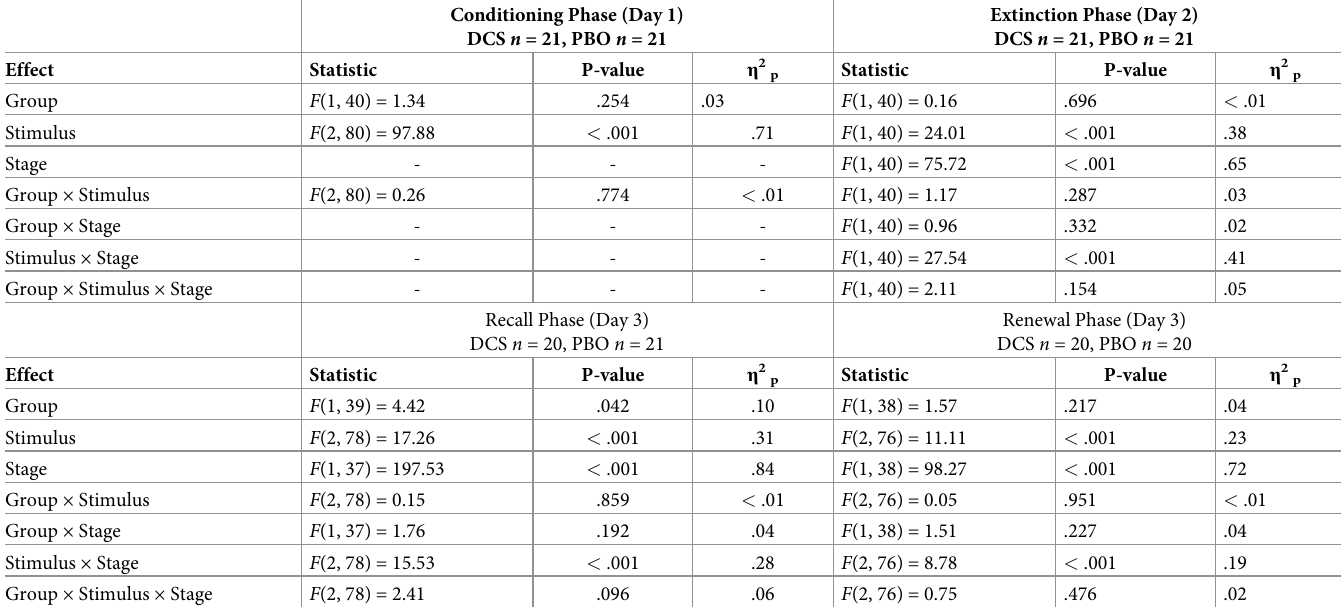
Table 2. US expectancy results from ANOVAs across experimental